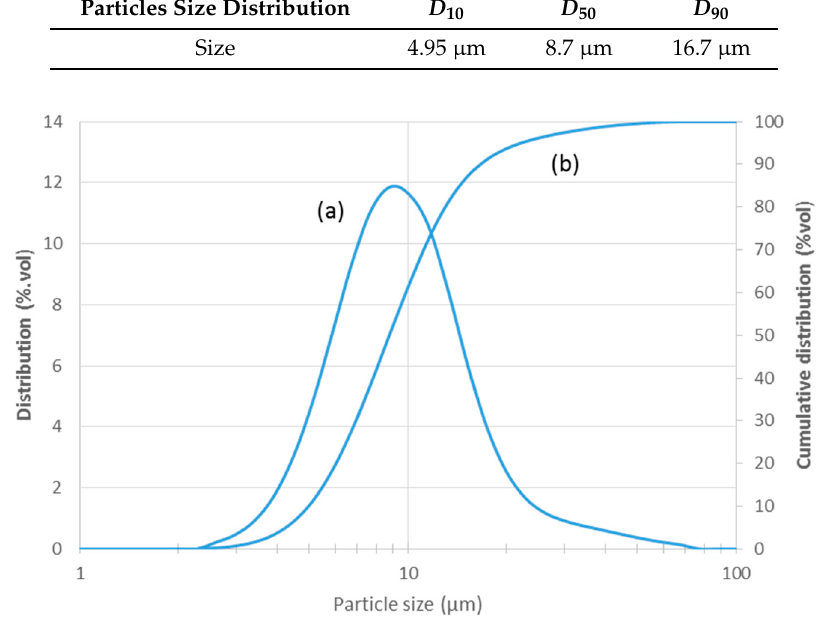
Figure 1. Size distribution ( a ) and cumulative volume ( b ) of the Inconel 718 powder.